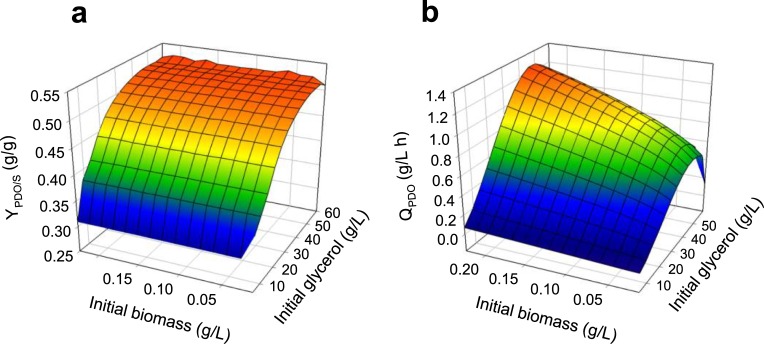
Response surfaces predicted by DFBA, varying initial concentration of biomass and glycerol in batch culture.(a). Predicted glycerol conversion to PDO yield (YPDO/S). (b) Predicted PDO productivity (QPDO).